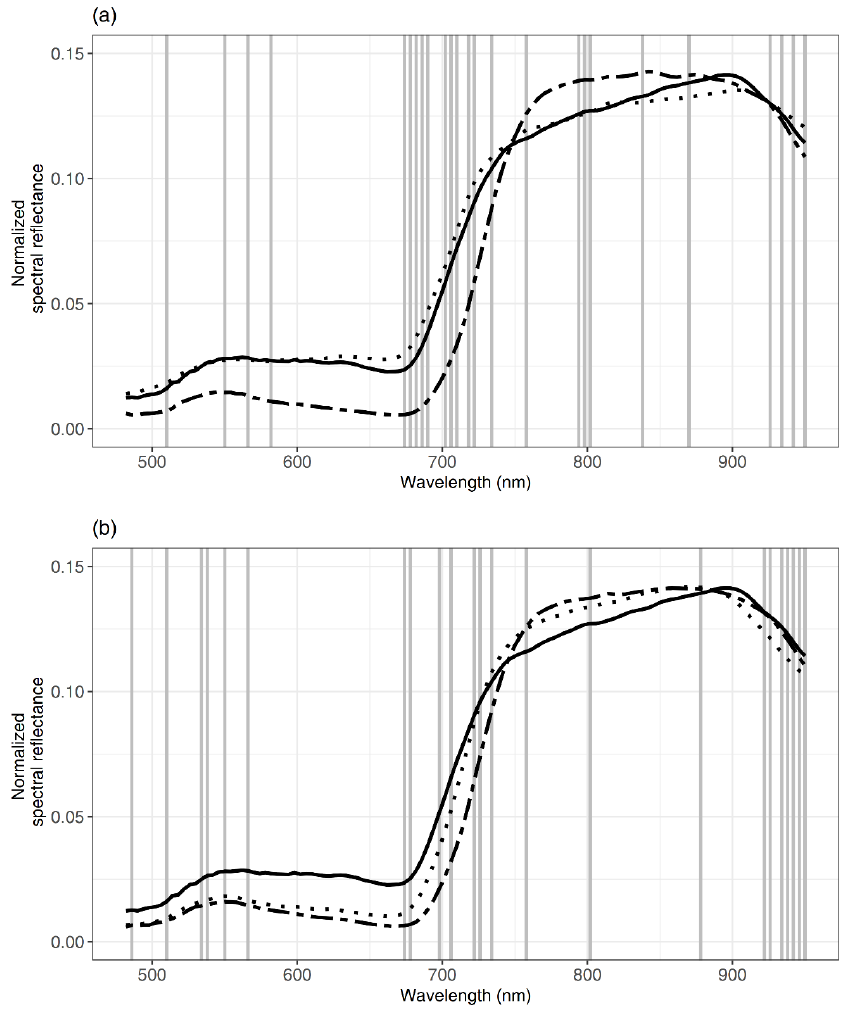
Figure 4. Normalized spectral reflectance curve for the minimum (solid), maximum (two dashes) and median (dotted) yield values of ( a ) fresh matter yield and ( b ) dry matter yield. The gray lines in the background show the selected most important wavebands used for the model calibration ( n = 25 and 23 for FMY and DMY). The band selection for FMY and DMY using VSURF reduced the number of spectral bands. For FMY and DMY, 25 and 23 wavebands were selected. The identified most im-